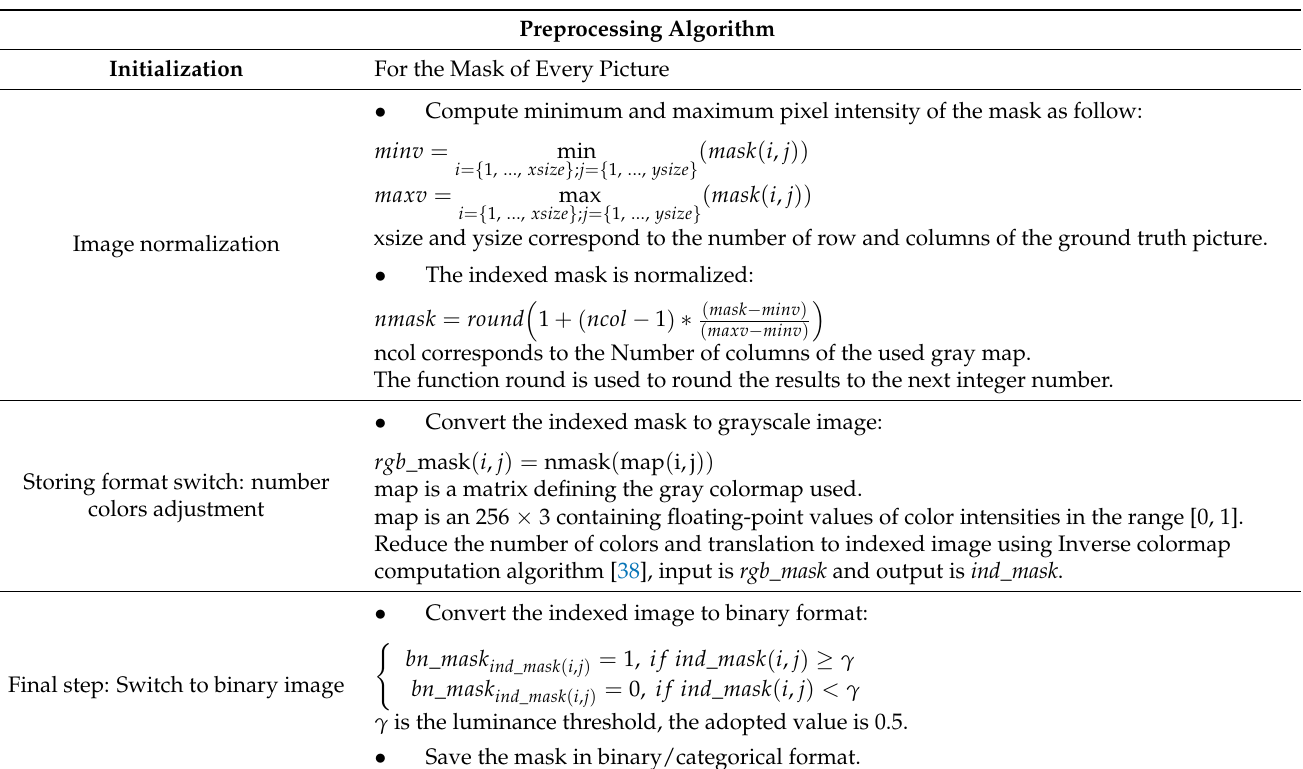
Table 2. Firefront_Gestosa ground truths preprocessing. Preprocessing